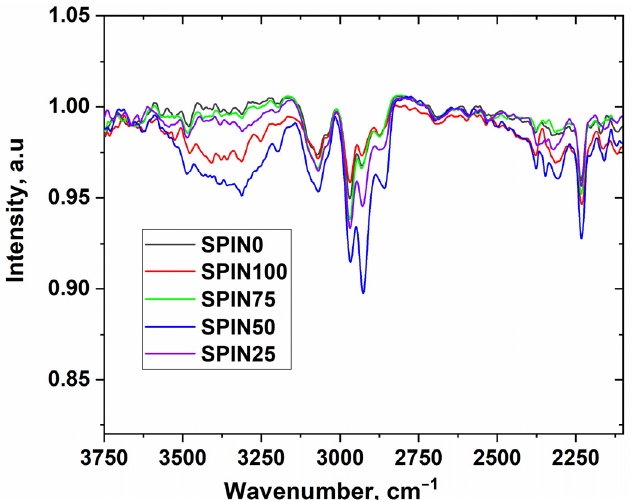
Figure 5. FTIR spectra of the analyzed compounds in the range of 3750–2100 cm − 1 .